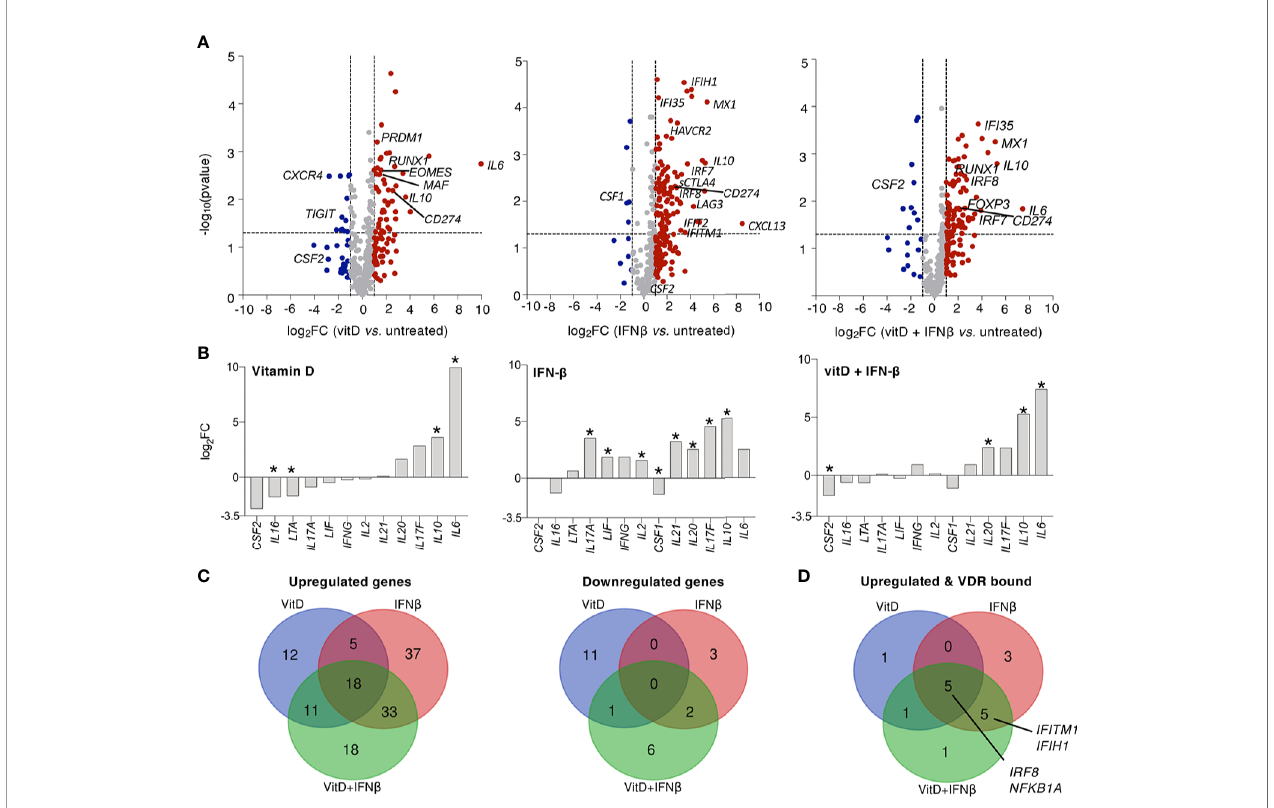
FIGURE 3 | Vitamin D and IFN- b regulate the expression of immune transcripts in CD4 + T lymphocytes. (A) T CM cells (2 – 5 independent donors) were treated for 5 days in the presence or absence of vitamin D and/or IFN- b and the expression of immune-relevant genes was determined by Nanostring pro fi ling. (B) Same as (A) , but focusing on the expression of selected cytokines. The asterisk (*) indicates signi fi cant values (p<0.05). (C) Venn diagrams showing the extent of overlap between the different treatments. (D) Venn diagram showing the intersection between genes upregulated upon treatment and genes that were described to be bound directly by VDR by ChIP-seq